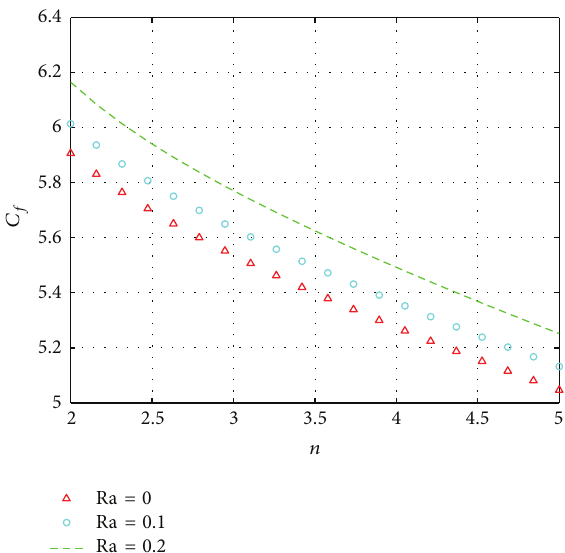
Figure 7: Effects of magnetic field on velocity; 𝑡 = 50 .